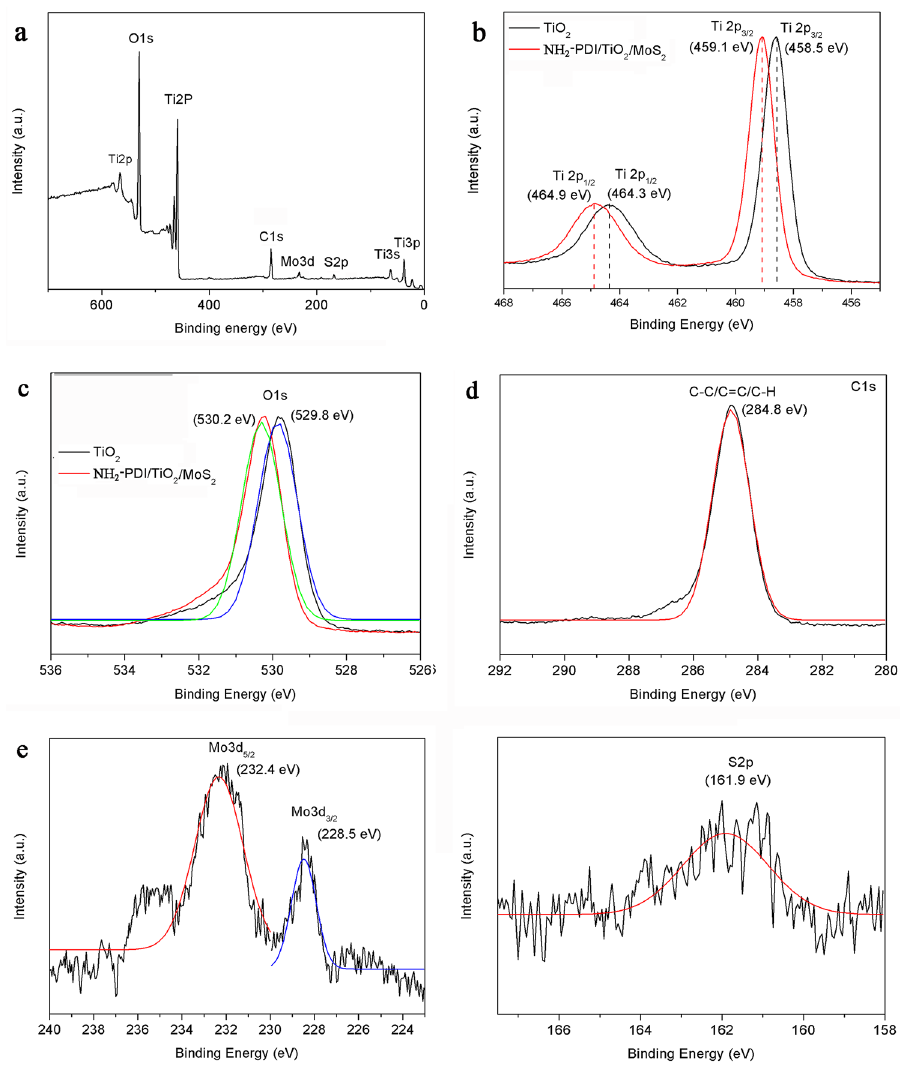
Figure 5. XPS spectra of ( a ) survey spectra in NH 2 -PDI/TiO 2 /MoS 2 , ( b ) Ti2p in pure TiO 2 and NH 2 -PDI/TiO 2 / MoS 2 , ( c ) O1s in pure TiO 2 and NH 2 -PDI/TiO 2 /MoS 2 , ( d ) C1s in NH 2 -PDI/TiO 2 /MoS 2 , ( e ) Mo3d in NH 2 -PDI/ TiO 2 /MoS 2 , and ( f ) S2p in NH 2 -PDI/TiO 2 /MoS 2